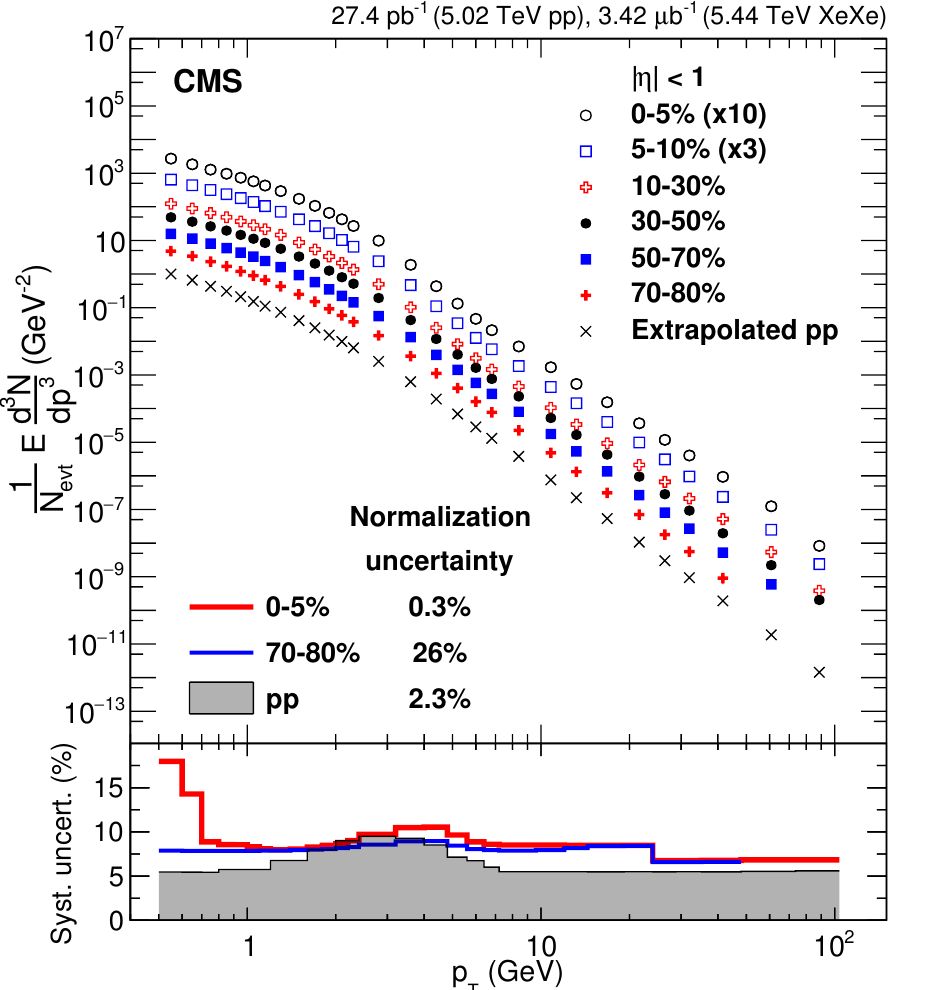
Figure 3 . (Upper panel) The charged-particle p T spectra in six classes of XeXe centrality and the p pp reference spectrum after being extrapolated to s = 5 : 44 TeV. The statistical uncertainties are smaller than the markers for many of the points. To facilitate direct comparison, the pp points are converted to per-event yields using a constant factor of 70 mb. (Lower panel) The systematic uncertainties for central and peripheral XeXe collisions, as well as for the pp reference